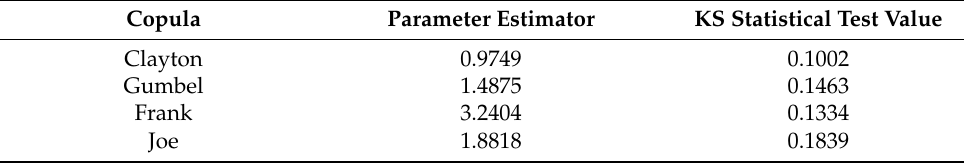
Table 2. The parameter estimators and KS statistical test value of